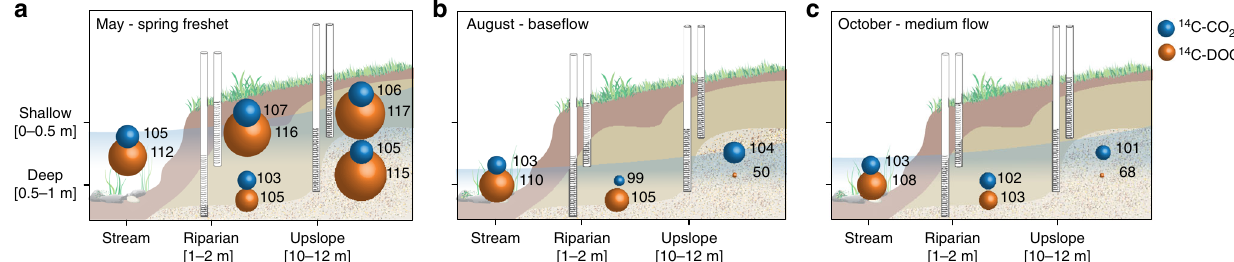
Fig. 2 Groundwater and stream water 14 C-CO 2 and 14 C-DOC at the transect scale. Catchment schematic (unscaled) illustrating the 14 C-CO 2 (blue spheres) and 14 C -DOC (orange spheres) expressed in %modern. The size of the spheres is proportional to the 14 C content and speci fi c values are written on the right side of each sphere. The measurements were made along the Upslope-Riparian-Stream transect, at shallow (0 – 0.5 m) and deep (0.5 – 1 m) groundwater depths, in a May 2015, b August 2015, c October 2015. The original 14 C data are listed in Supplementary Table 2